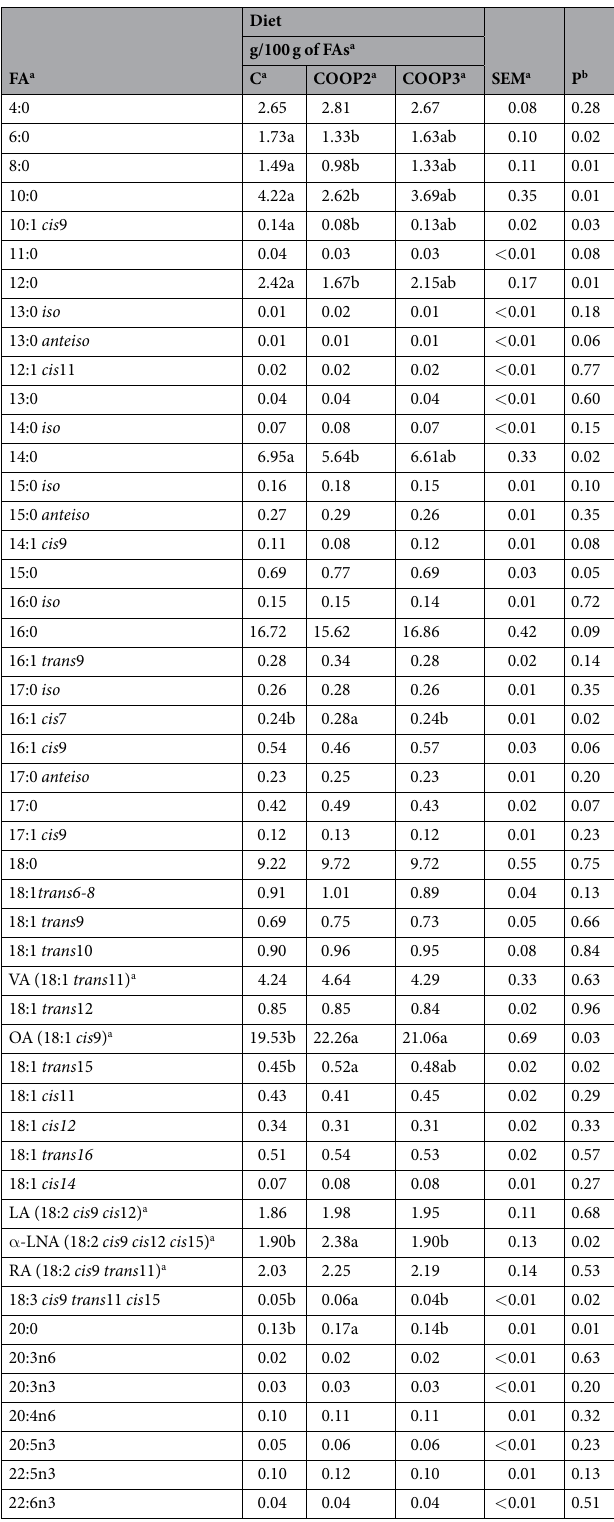
Table 4. Effect of olive oil pomaces on FAs a production in milk. a Acronyms used in this table: FA (fatty acid), C (control diet), COOP2 (control diet added with olive oil pomace extracted with a two-phase procedure), COOP3 (control diet added with olive oil pomace extracted with a three-phase procedure), OA (oleic acid), VA (vaccenic acid), LA (linoleic acid), α -LNA ( α linolenic acid), RA (rumenic acid) and SEM (Standard Error Mean). b Probability of significant effect due to experimental diets; means within a row with different letters differ (P <